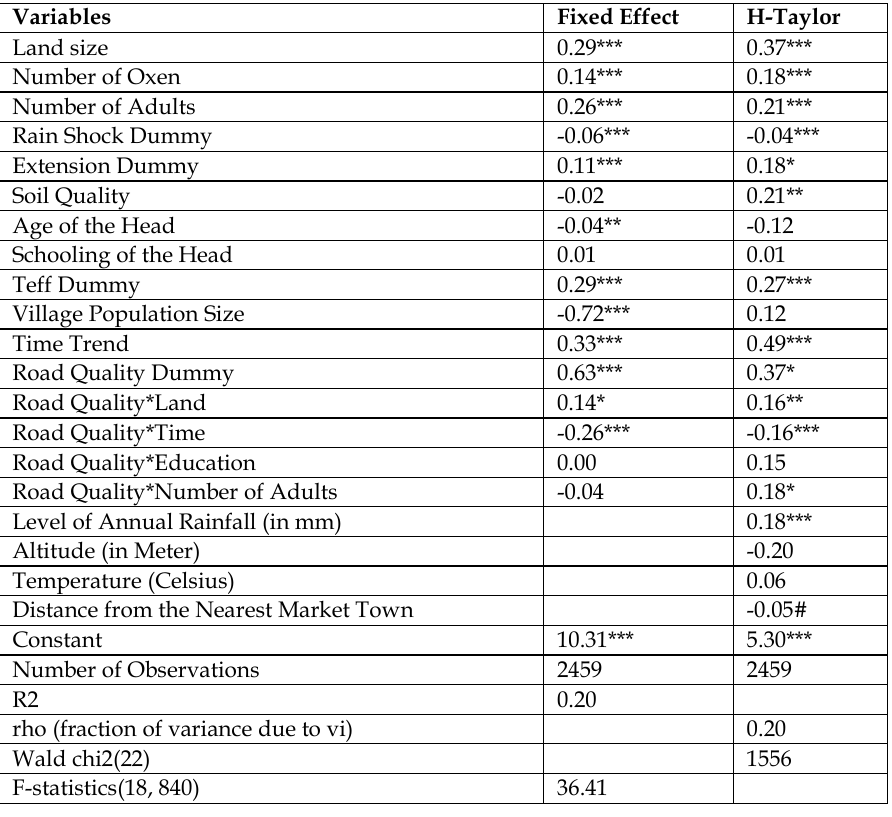
Table 1. The Impact of Road Quality on Income: The Estimation Results